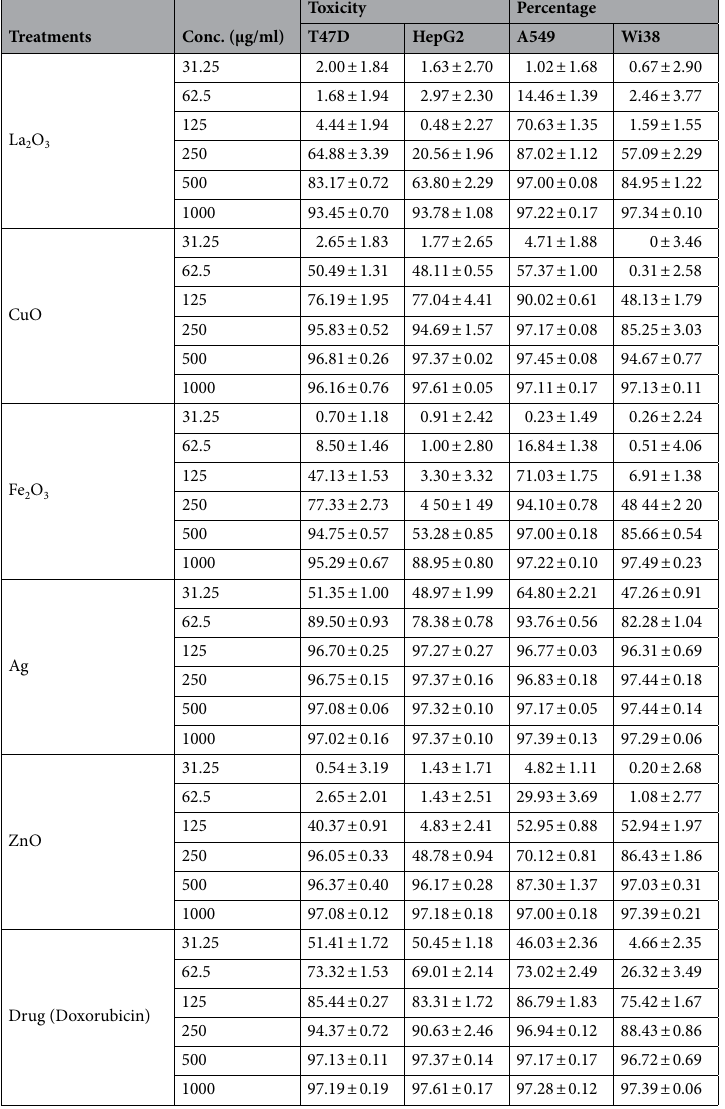
Table 2. Anticancer activity of different biosynthesized nanoparticles from M. oleifera .